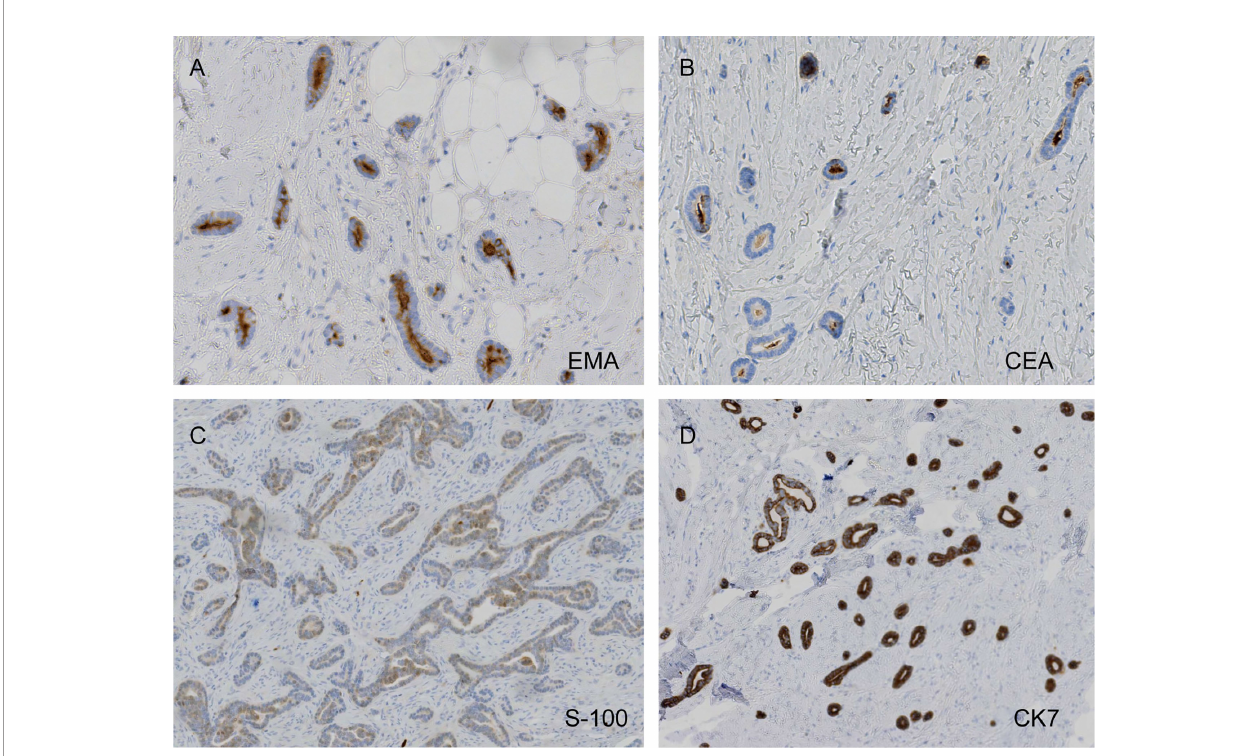
FIGURE 4 | Carcinoembryonic antigen (CEA) and epithelial membrane antigen (EMA) positivity, weak protein S-100 weakly positivity, and diffusely strong cytokeratin 7 (CK7) positivity ( A , EMA, ×200; B , CEA, ×200; C , S-100, ×100; D , CK7,